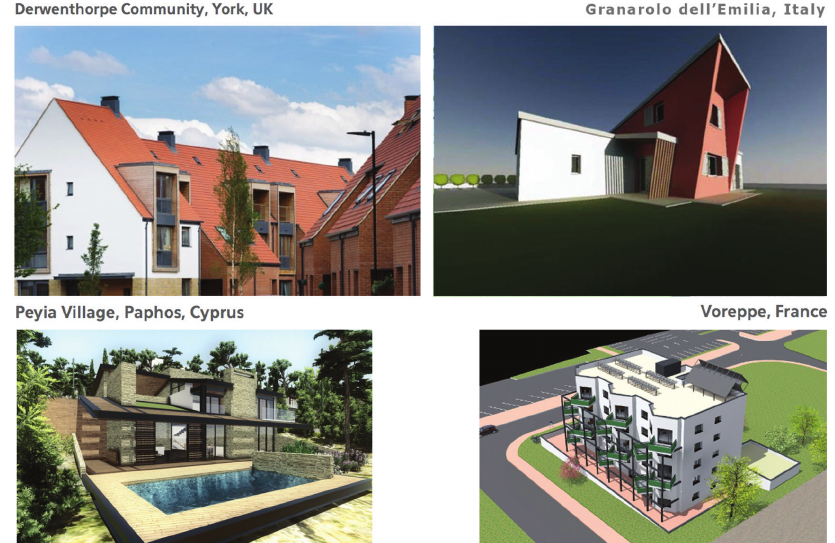
Figure 1. The four case study settlements of ZERO-PLUS. Source: